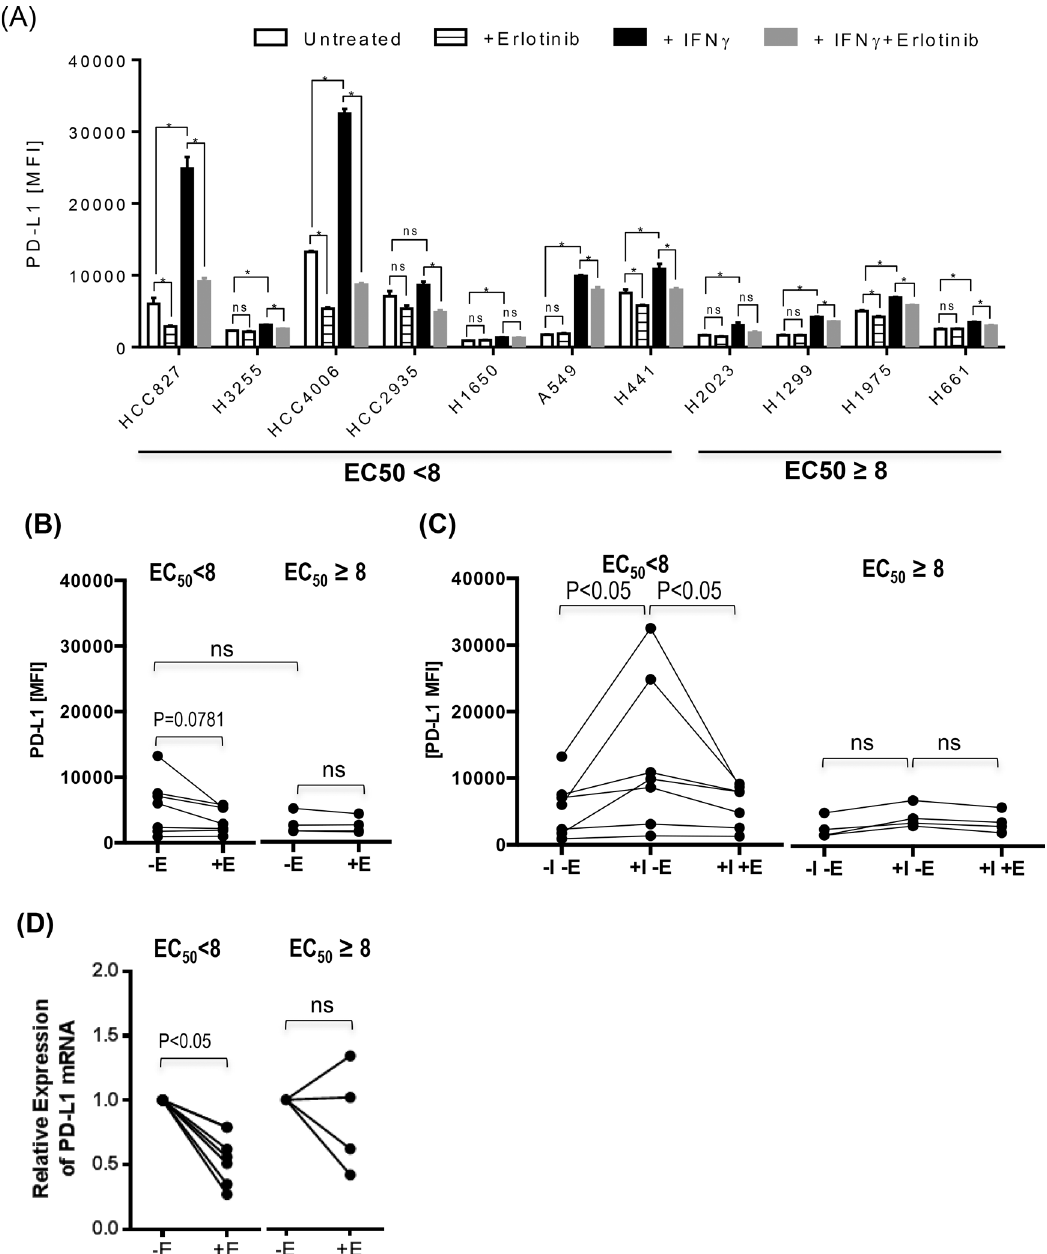
Fig 4. EGFR inhibitor down-regulates the PD-L1 expression on lung cancer cell lines. Various lung cancer cell lines were treated with IFN γ at a concentration of 1000 pg/ml in the presence or absence of erlotinib at concentration of 10 μ M for 24 hours, and assessed for surface expression of PD-L1. (A) The average MFIs ± SD of PD-L1 staining were represented as bar graphs in (A) (B and C) Lung cancer cell lines were divided into two groups according to EC 50 (EC 50 < 8 vs EC (cid:2) 8) of erlotinib, and average MFI of PD-L1staining for individual cell line was represented as a single dot in 50 dot plots for further statistical analysis to assess the influence of IFN γ and/or erlotinib on PD-L1 expression. There was a trend toward higher expression of PD-L1 in untreated lung cancer cell lines sensitive to erlotinib, and erlotinib treatment down-regulated PD-L1 expression on lung cancer cell lines sensitive to erlotinib but not statistically significant (B). The treatment with IFN γ significantly up-regulated the expression of PD-L1 proteins on lung cancer cell lines sensitive to erlotinib, and the addition of erlotinib significantly inhibited IFN γ -induced PD-L1 overexpression on lung cancer cell lines sensitive to erlotinib (C). Abbreviation used in this experiment is as follows. E: Erlotinib, I: IFN γ . The experiment shown here was performed in triplicates, and a representative of three independent experiments. (D) Various lung cancer cells were cultured in the presence or absence of erlotinib at a concentration of 10 μ M for 24 hours, and the total RNA